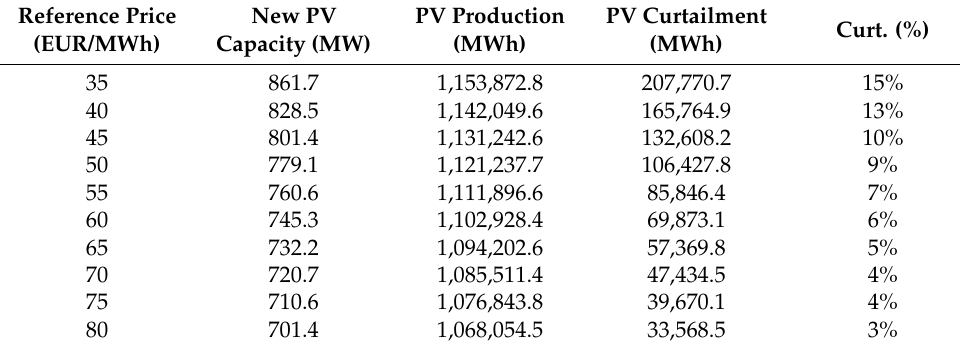
Table 1. Results for the first period.